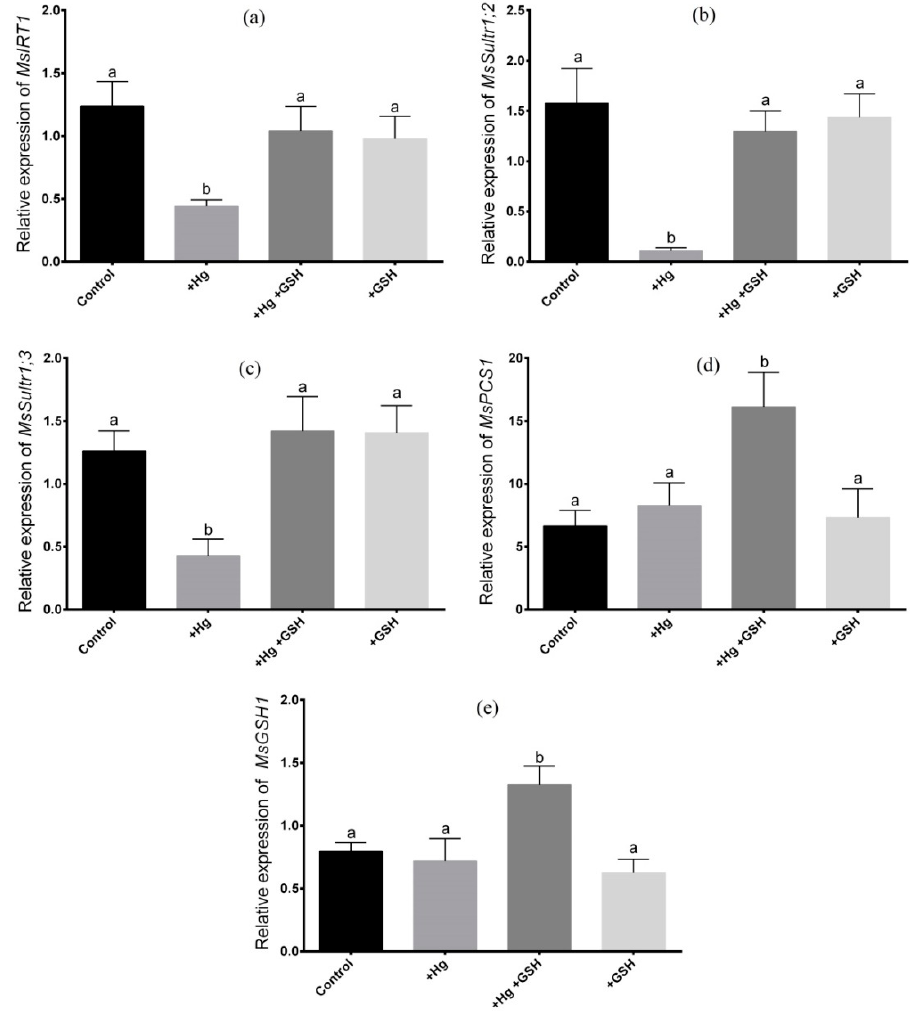
Figure 5. Expression analysis of candidate genes in roots of alfalfa. Relative expression of MsIRT1 ( a ),